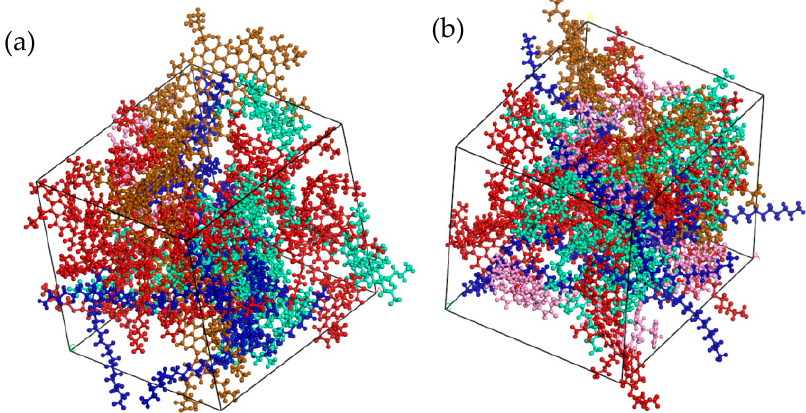
Figure 4. Two molecular models of modified asphalt: ( a ) PG76-22 modified asphalt (SBS modifier parameters 4.27%); ( b ) S-HV (SBS modifier parameters 11.8%). Table 1. Detailed composition of three asphalt materials.